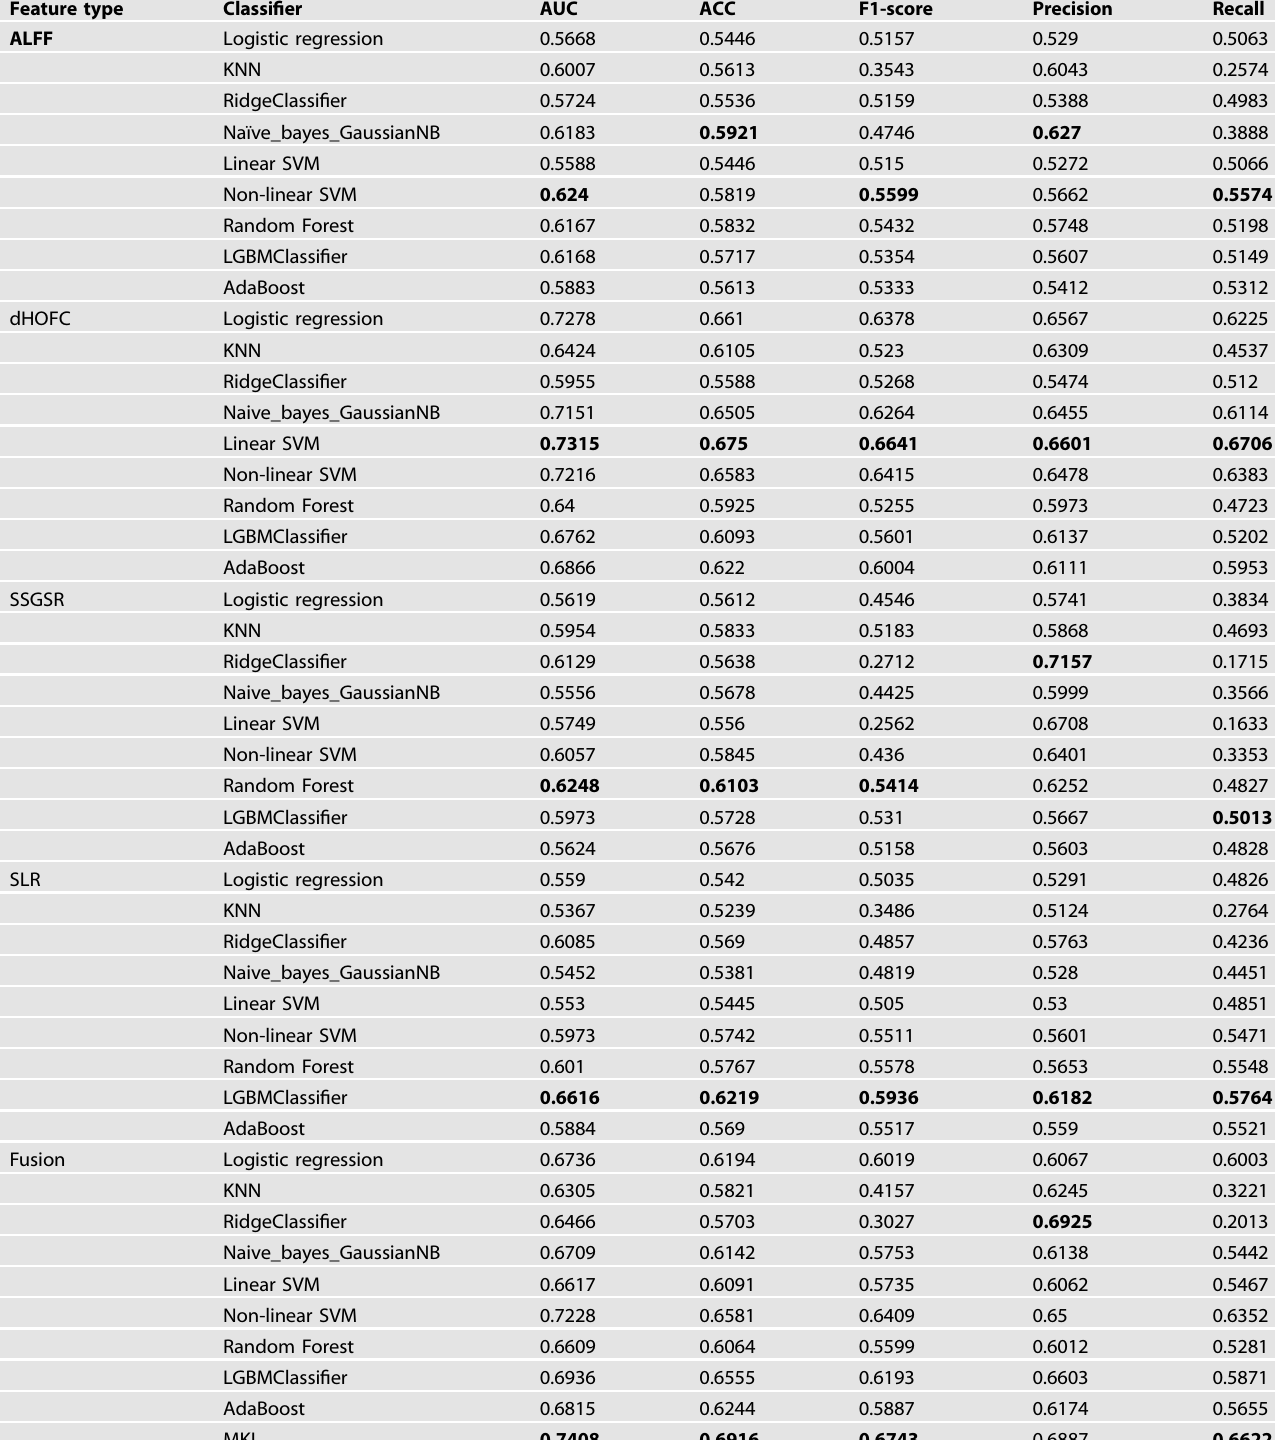
Table 4. Classi fi cation performance of different measures and multi-modal fusion